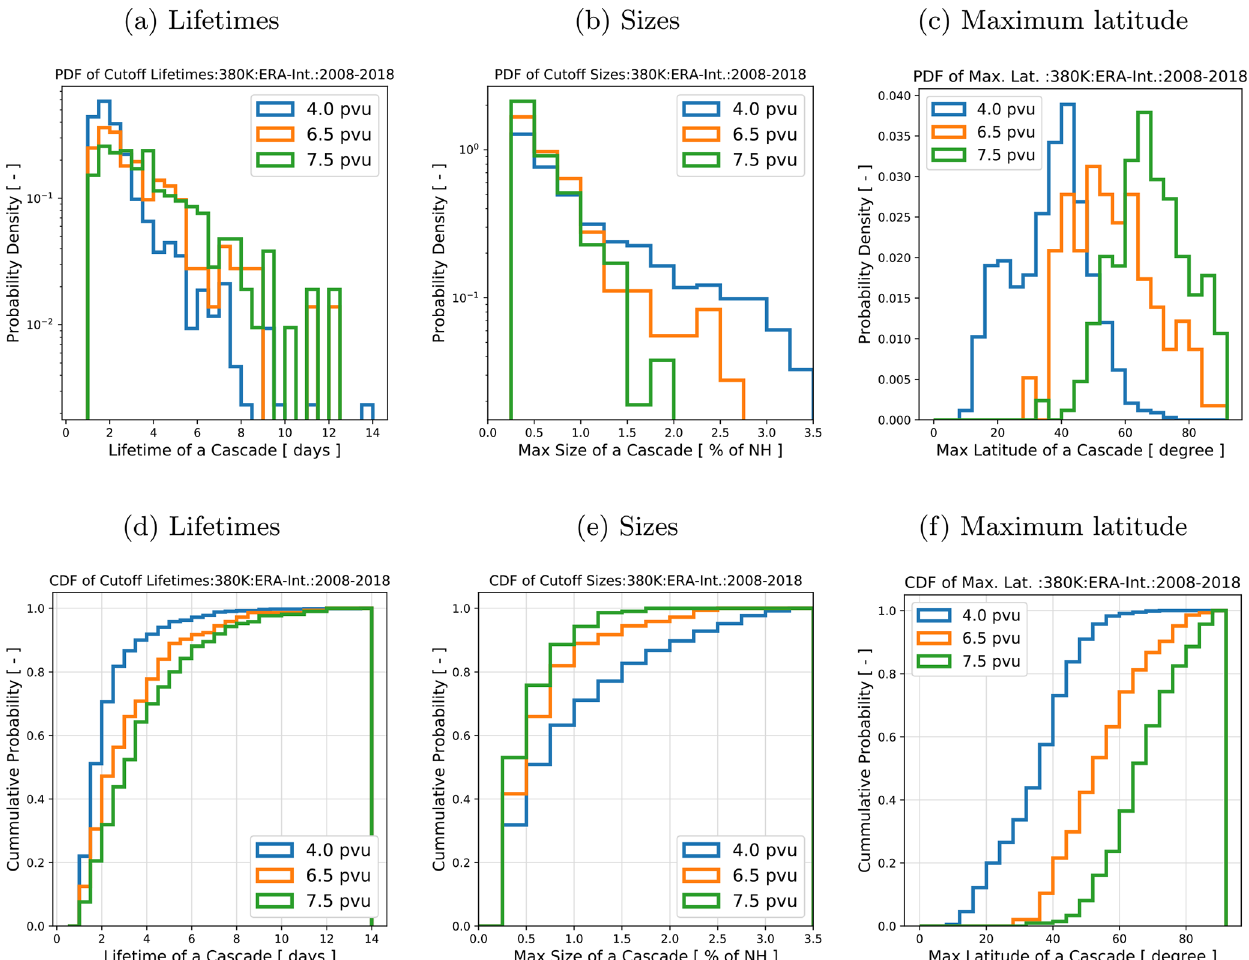
Figure 6. PDFs (a–c) and CDFs (d–f) for the lifetime, size, and maximum latitude of ASMA-related cutoffs at 380K between 2008 and 2018. The frequencies are determined from the number of